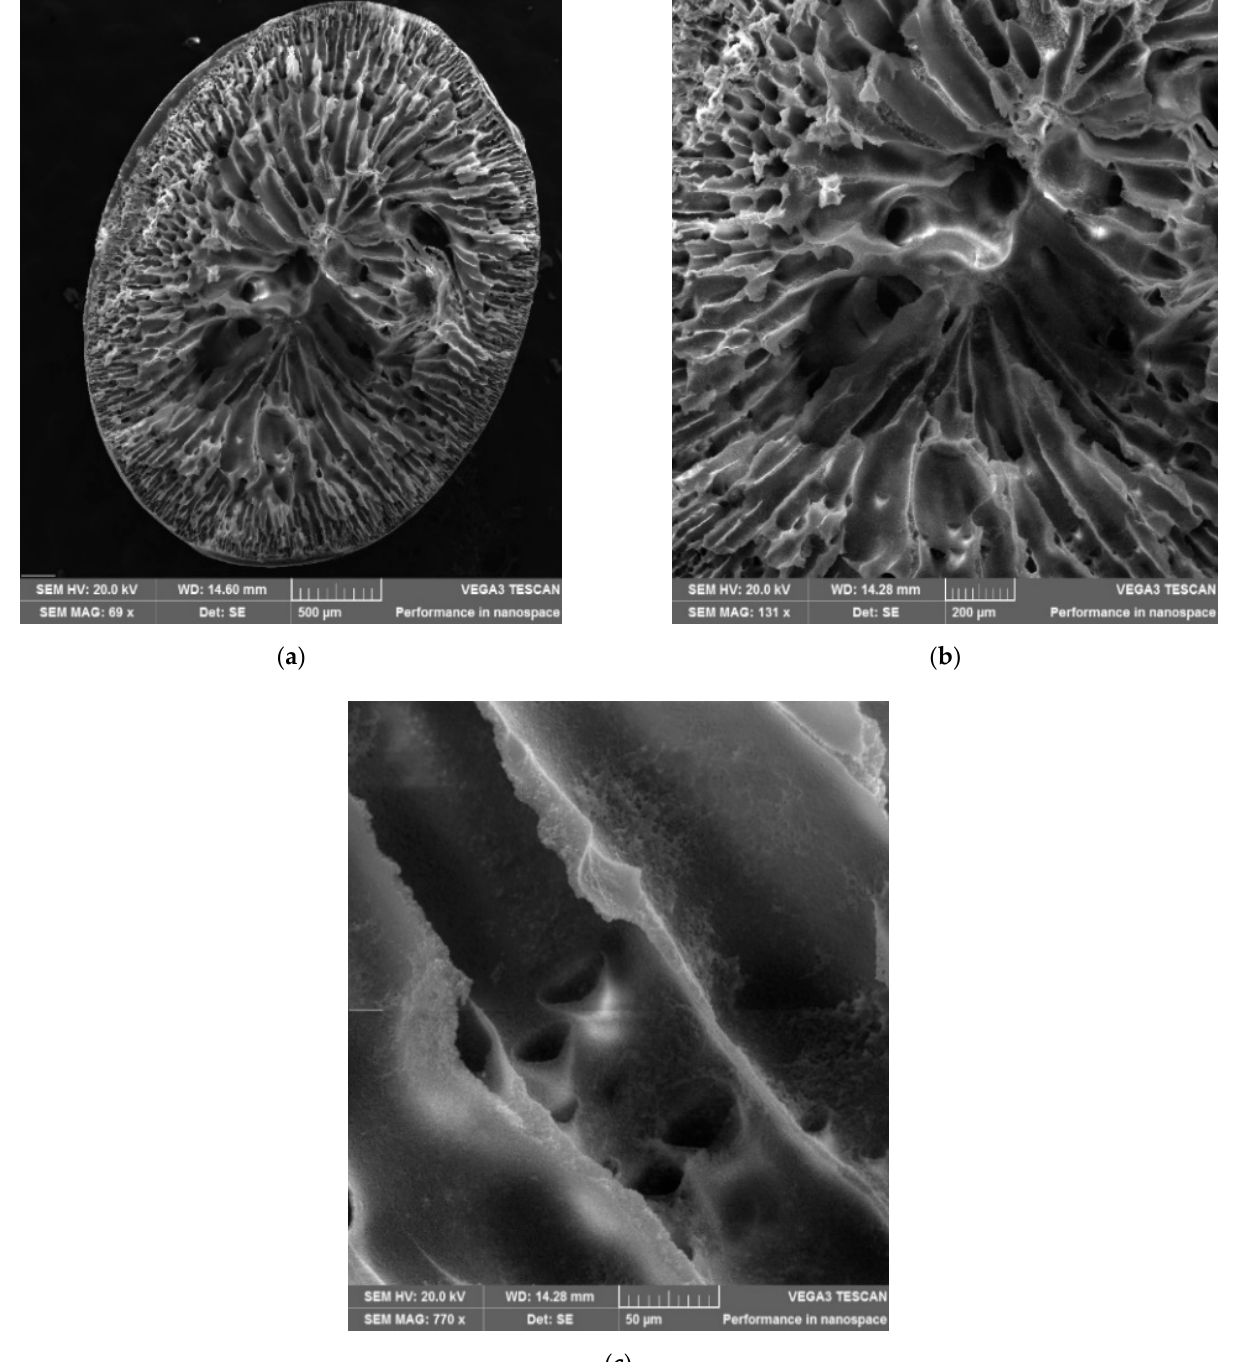
Figure 7. SEM images of the internal porous network of a mesoporous composite polymer monolith: ( a ) image showing the entire porous network of the spherical monolith; ( b ) image highlighting the various pore sizes and morphologies within the monolith; ( c ) a close-up image revealing spherical pores within the finger-like pores, emphasizing the existence of an interconnected porous system.